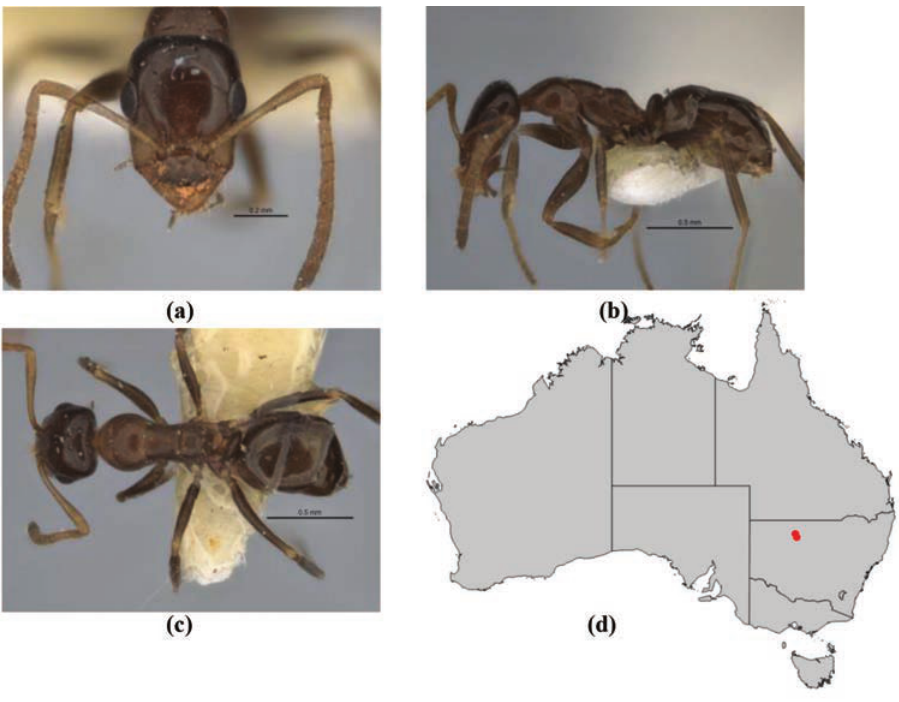
Figure 40. Melophorus longiceps sp. n.: minor worker holotype (ANIC32-900104) frons ( a ), profile ( b ) and dorsum ( c ); distribution map for the species ( d ). Low resolution scale bars: 0.5 mm ( b, c ); 0.2 mm ( a ). oblique. Mesosoma . Integument of pronotum, mesonotum and mesopleuron with weak to moderate sheen, shagreenate on pronotum and dorsum of mesonotum, other- wise microreticulate; anterior mesosoma in profile weakly elevated anteriad, thereafter gently sinuate, pronotum and mesonotum on same plane; erect pronotal setae absent; in profile, metanotal groove shallow, indicated mainly by an angle; propodeum matt or with a weak sheen and microreticulate; propodeum angulate, propodeal angle blunt, or distinctly angulate, propodeal angle sharp; length ratio of propodeal dorsum to its de- clivity about 1:1; erect propodeal setae always absent; appressed propodeal setulae short, separated by more than own length and inconspicuous; propodeal spiracle situated on or beside declivitous face of propodeum, and shorter (length < 0.50 × height of propo- deum). Petiole . In profile, petiolar node squamiform; in full-face view, shape of petiolar node uniformly rounded; node shining and distinctly microreticulate. Gaster . Gaster shining, shagreenate (‘LP record’ appearance); pilosity of first gastral tergite consist- ing of well-spaced short, inconspicuous, appressed setae only, erect setae always absent. General characters . Colour uniformly chocolate with some tan highlights . Measurements. Worker (n = 2): CI 76–81; EI 30–38; EL 0.15–0.16; HL 0.56– 0.63; HW 0.43–0.51; ML 0.72–0.82; MTL 0.41–0.43; PpH 0.07–0.10; PpL 0.29– 0.34; SI 111–121; SL